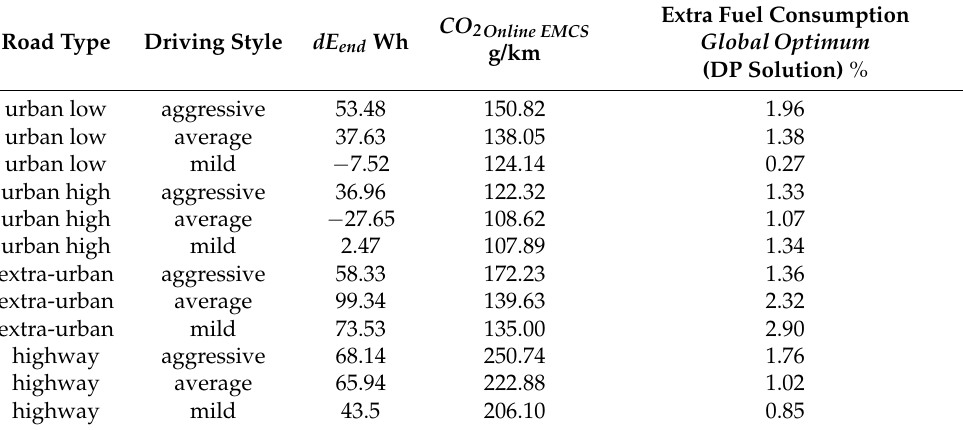
Results of the non-predictive Online ECMS for λ 0 = 3.01, kp SOC = 191.92, and | dE | < 100 Wh for an unlimited end